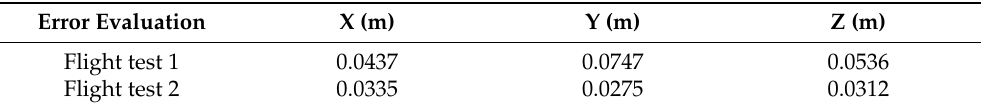
Table 1. Calculated RMSE of UAV position